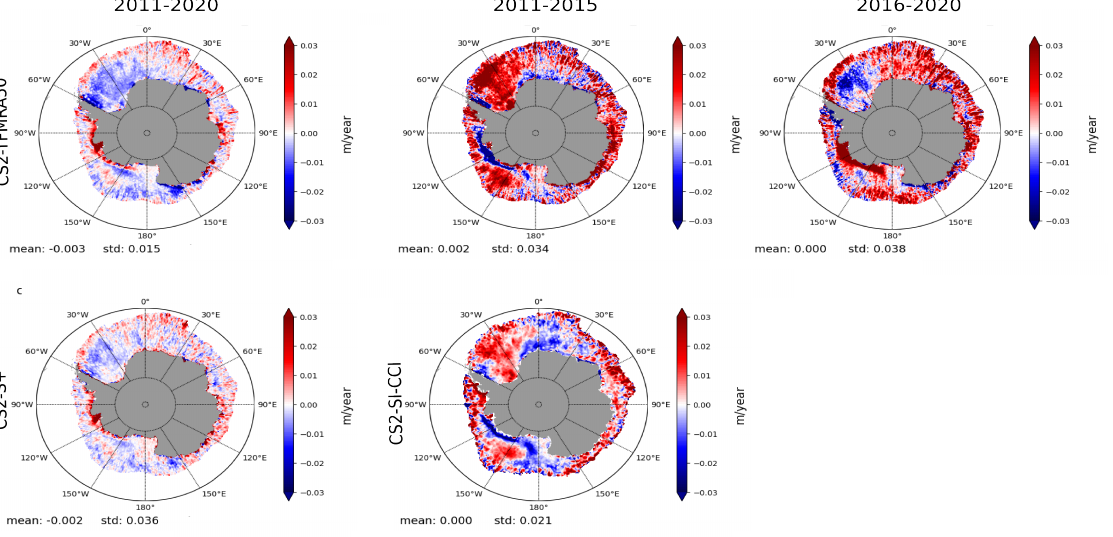
Figure 2. Maps of radar freeboards trends for the 2011–2020 (first column), the 2011–2015 (second column) and the 2016–2020 (third column) time periods. The 3 maps of the first line are derived from the CryoSat-2 TFMRA-50 (CS2-TFMRA50) dataset. The second line presents the maps obtained